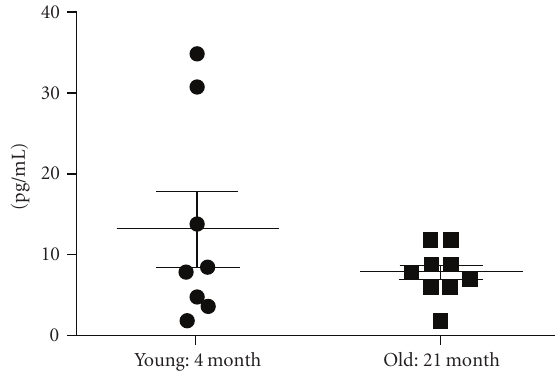
Figure 4: Serum estradiol. Entries show the average ± SEM and individual values for young ( n = 8) and aged ( n = 9)